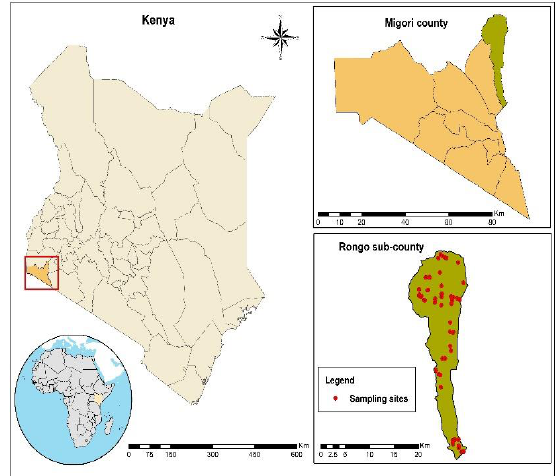
Figure 1: Domain and geographic location of the study area in Kenya and Migori subcounty.